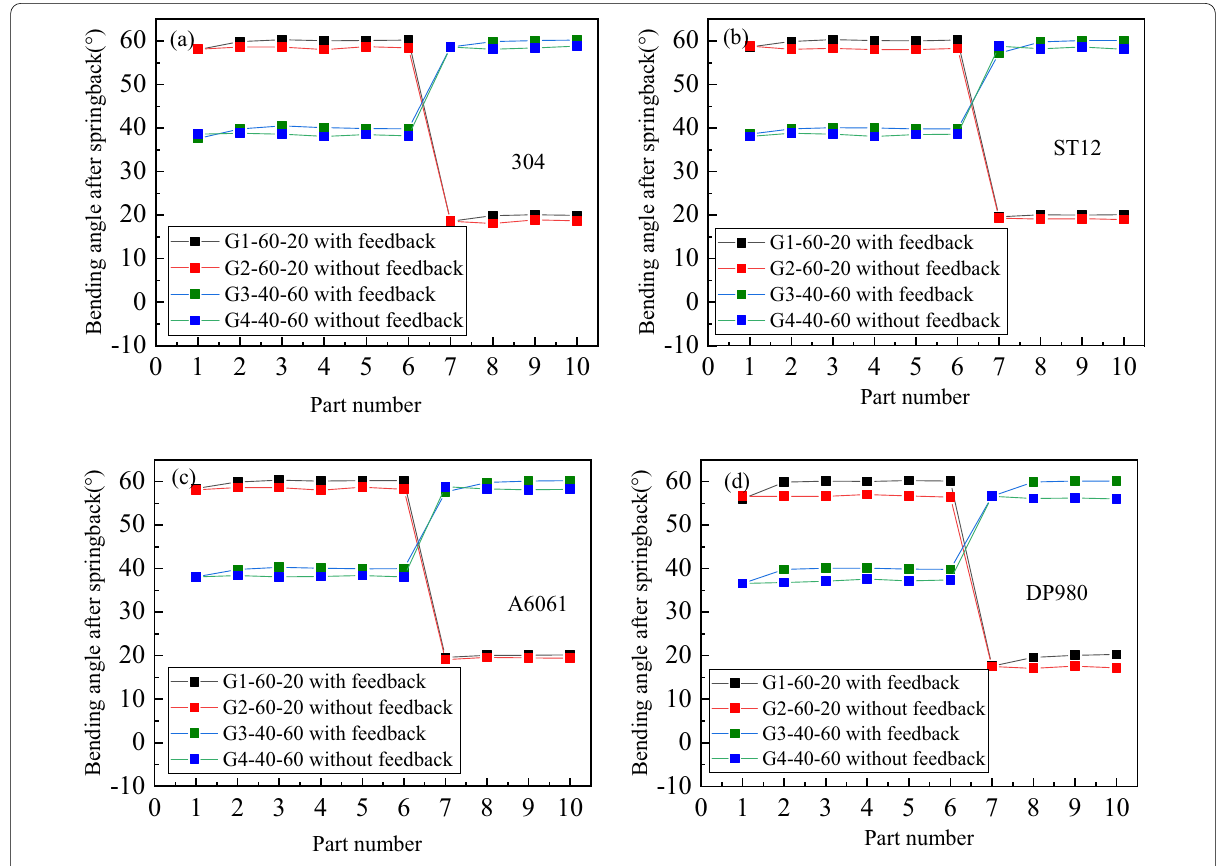
Figure 21 Curves of bending angle after springback: a SUS304, b ST12, c AL6061, d